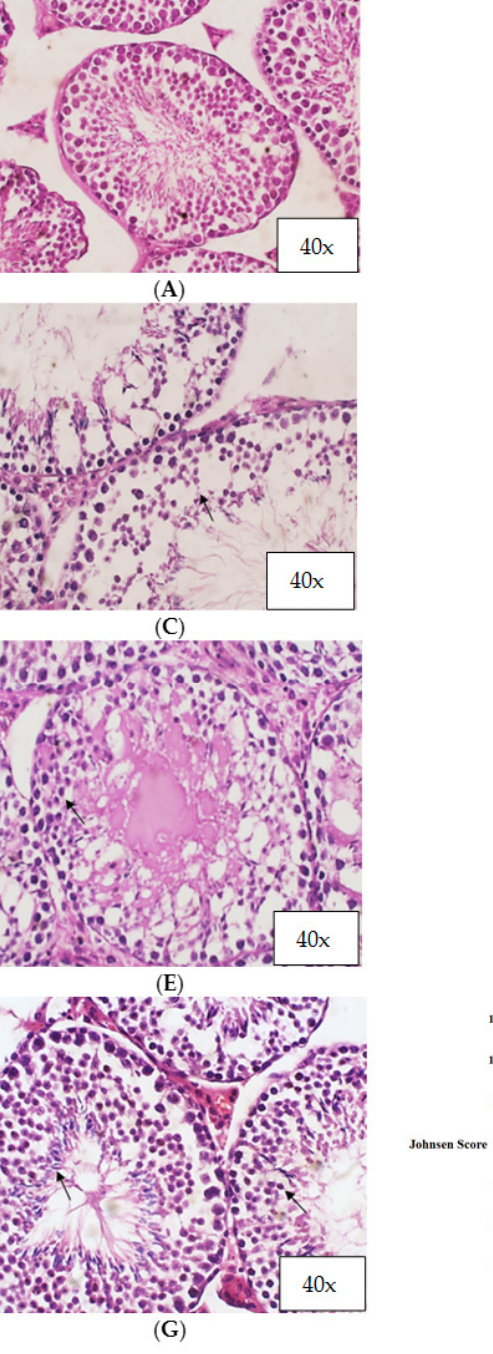
Figure 4. Histopathological examination of the effects of C. endivia L. crude extract, phenolic fraction, and its isolated compounds (coumaric, vanillic, and ferulic acids) on the testicular tissue in the experimental mice (40 × ). ( A ) Normal control group, ( B ) MTX control group, ( C ) C. endivia L. crude- extract-treated group, ( D ) C. endivia L. phenolic-extract-treated group, ( E ) coumaric acid treated group, ( F ) vanillic acid treated group, ( G ) ferulic acid treated group, and ( H ) bar charts representing Johnsen’s scoring for the testes in the studied groups. Black arrows refer to spermatogenesis. Data are expressed as the mean ± SD. Data were analyzed using one-way ANOVA then Bonferroni’s post hoc test. * Significant against normal control group, # significant against MTX control group. Values were considered significantly different at p <